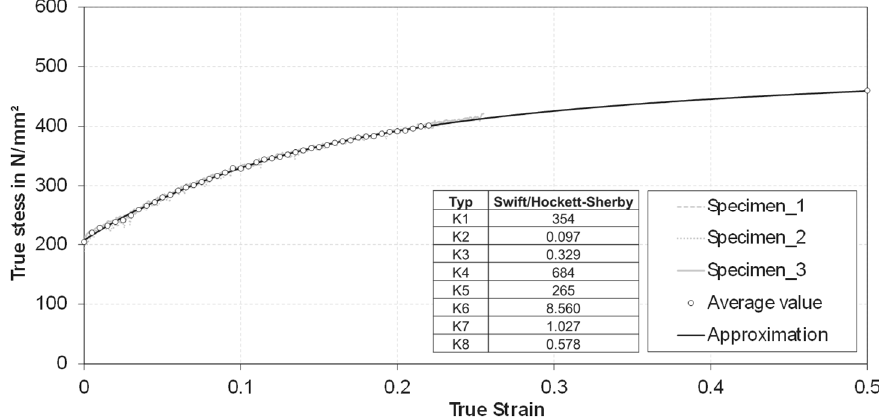
Figure 8. The yield curve of the material DC06 for an actual strain rate of 0.08/s. In Equation (3), σ F is the yield stress and ϕ is the degree of deformation. An Excel solver was used to adjust the function to the measured flow curve and to calculate the parameters K 1 to K 8 . Figure 8 also provides the calculated parameters and the approximated yield curve at an actual strain rate of 0.08/s. There is a very good agreement between the calculated and measured values.